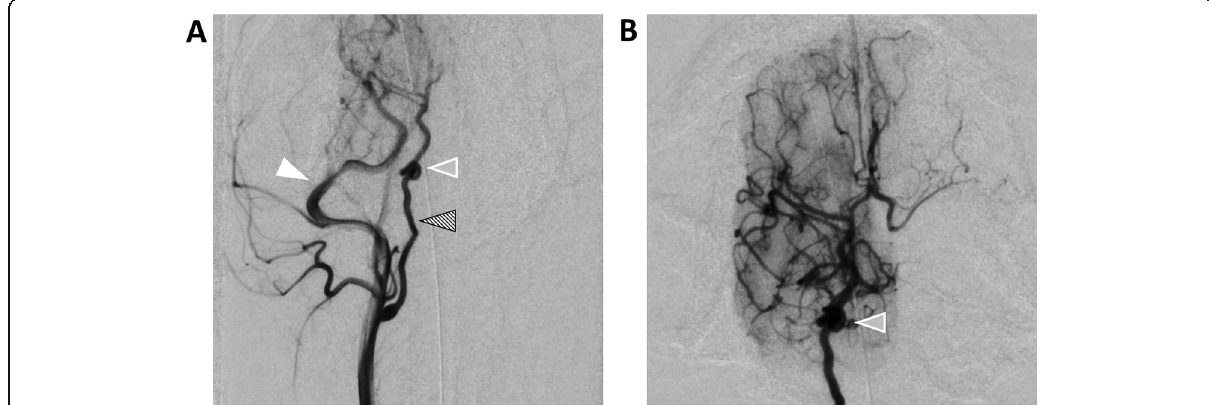
Fig. 4 Angiography of P1 prior to infusion of 90 Y-RE. a Common carotid artery angiogram detailing the dominant external carotid artery (solid white arrow), extracranial ICA (crosshatched arrow), and tortuosity of the ICA as it enters the skull base (gray arrow). b ICA